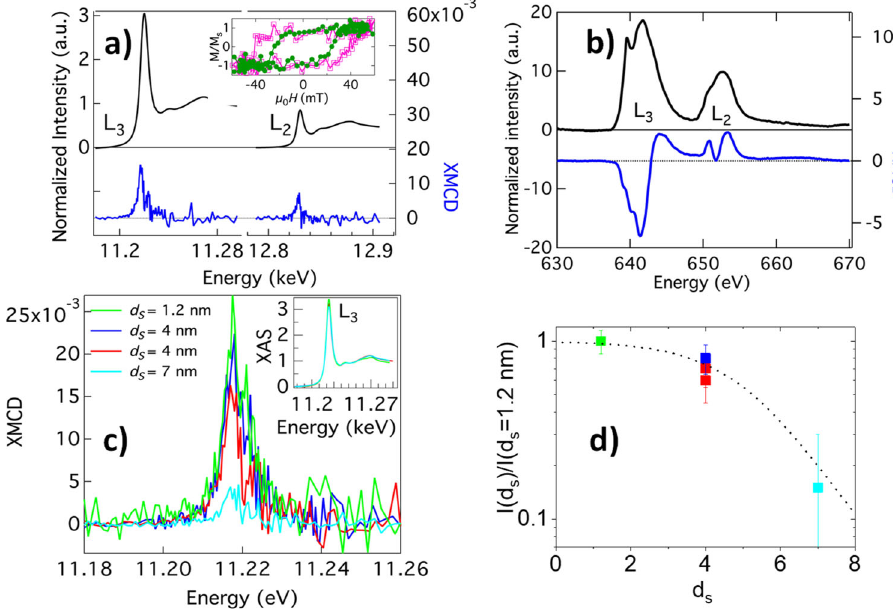
Fig. 3 X-ray absorption spectroscopy. a Ir L 2,3 XAS (black lines) and XMCD (blue lines) PFY spectra measured at T = 20 K under a saturating magnetic fi eld of 55.6 mT applied in the [100] direction of a sample SrTiO 3 (100)//SrIrO 3 (4 nm)/La 0.7 Sr 0.3 MnO 3 (5 nm). Inset: L 3 Ir hysteresis loop measured at T = 20 K and E = 11.217 keV with in-plane magnetic fi elds along with the [100] (magenta open squares) and [110] (green circles) directions, measured from the fl uorescence and X-ray re fl ectivity intensities, respectively. b Mn XAS absorption spectra (black line) and XMCD (blue line) measured in the TEY mode at T = 50 K at remanence after saturating in a 280 mT magnetic fi eld applied in the [110] direction. c XMCD intensities for samples STO//SIO( d S )/ H = 60 mT. For d = 4 nm, two nominally identical samples were measured, at LSMO(5 nm) at the Ir L 3 edge. For d S = 1.2 nm and 7 nm, T = 10 K and μ S 0 various temperatures (20 K and 2 K) and magnetic fi elds (55.6 mT, 0.5 T). The intensity was independent of the magnetic fi eld applied. The peak intensity at 2 K is higher than those at 20 K. Inset: Normalized XAS intensity. d The ratio between measured XMCD peak intensities of samples with larger SIO thicknesses and the peak intensity of the sample with the thinnest SIO d S = 1.2 nm as a function of SIO